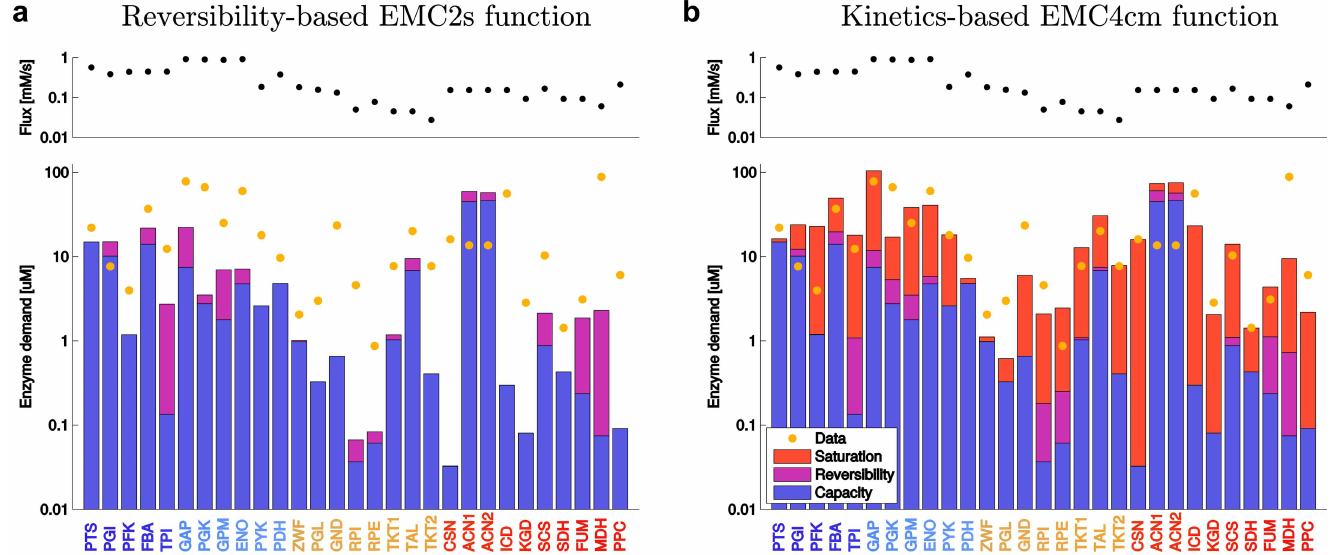
Fig 5. Enzyme demand in central metabolism. (a) Measured fluxes for all reactions (black dots on top) lead to an enzyme demand(bottom). The enzyme demand, predicted by using the reversibility-based EMC2s cost function, can be split into factors representingenzyme capacity and thermodynamics (see Methods). Bars show predicted enzyme levels in mM for individualenzymes on logarithmic scale. Yellow dots denote measured enzyme levels (in μ M). Note that the bars do not represent additive costs, but multiplicative cost terms on logarithmic scale; therefore, the relevant feature of the blue bars is not their absolute lengths, but their differences between enzymes. (b) The kinetics-based EMC4cm cost function includes saturation terms and yields more accurate predictions. Starting from the capacity cost (in blue), the reversibility (purple) and saturation (red) terms increase the enzyme demands and decrease the variabilitybetween enzymes (on log-scale).Note that flux data (circles) and protein data (yellow dots) are identicalin both plots.